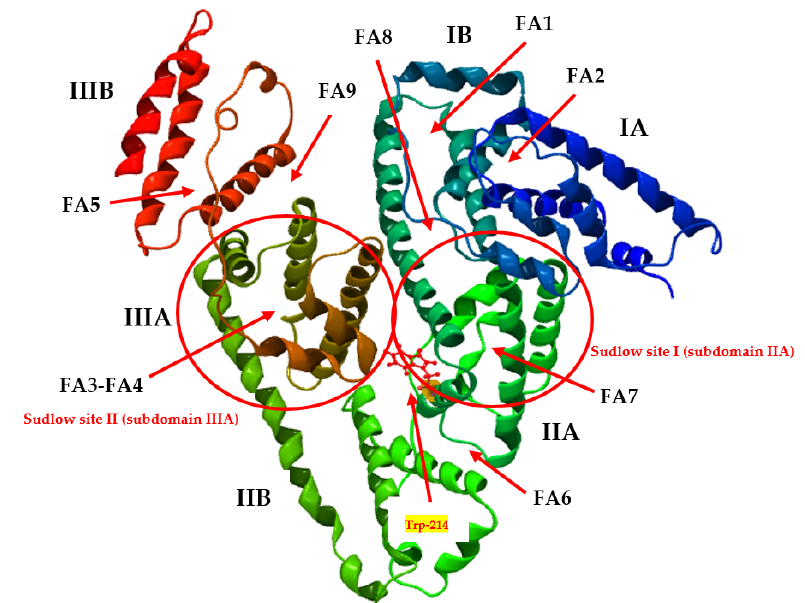
Figure 1. Human serum albumin (HSA) drug binding sites (Sudlow site I and II) with the location of main fatty acids in the HSA molecule (FA1–FA9) and the marked Trp-214 residue. Molecular graphic image based on [11] was produced using the CLC Drug Discovery Workbench version 1.0.2. (CLC Bio, a QIAGEN Company: Aarhus, Denmark) [license number: CLC-LICENSE-51JT8-DXYBY- 2A3EW-ED80P-DGW80] (PDB ID: 4K2C).